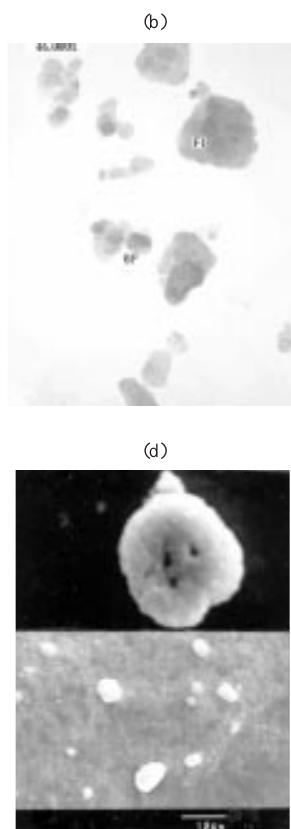
Figura 1. Fotomicrografias (MET) de partículas de caulinita da fração argila nas profundidades de 2,1 m (a e b) e 5,6 m (c ), com detalhe para as formas: alongada (Al), circular (C), indefinida (FI), 3 faces euédricas (3F) e 6 faces euédricas (6F), e micrografias (MEV) de partículas de caulinita da fração silte na profundidade de 2,1 m